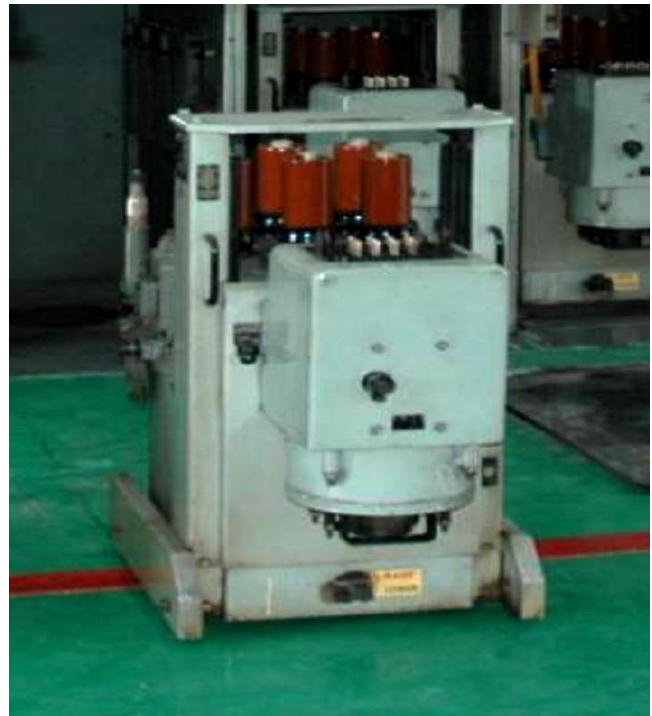
Figure 4. Sample of bulk/minimum oil circuit breaker [13].